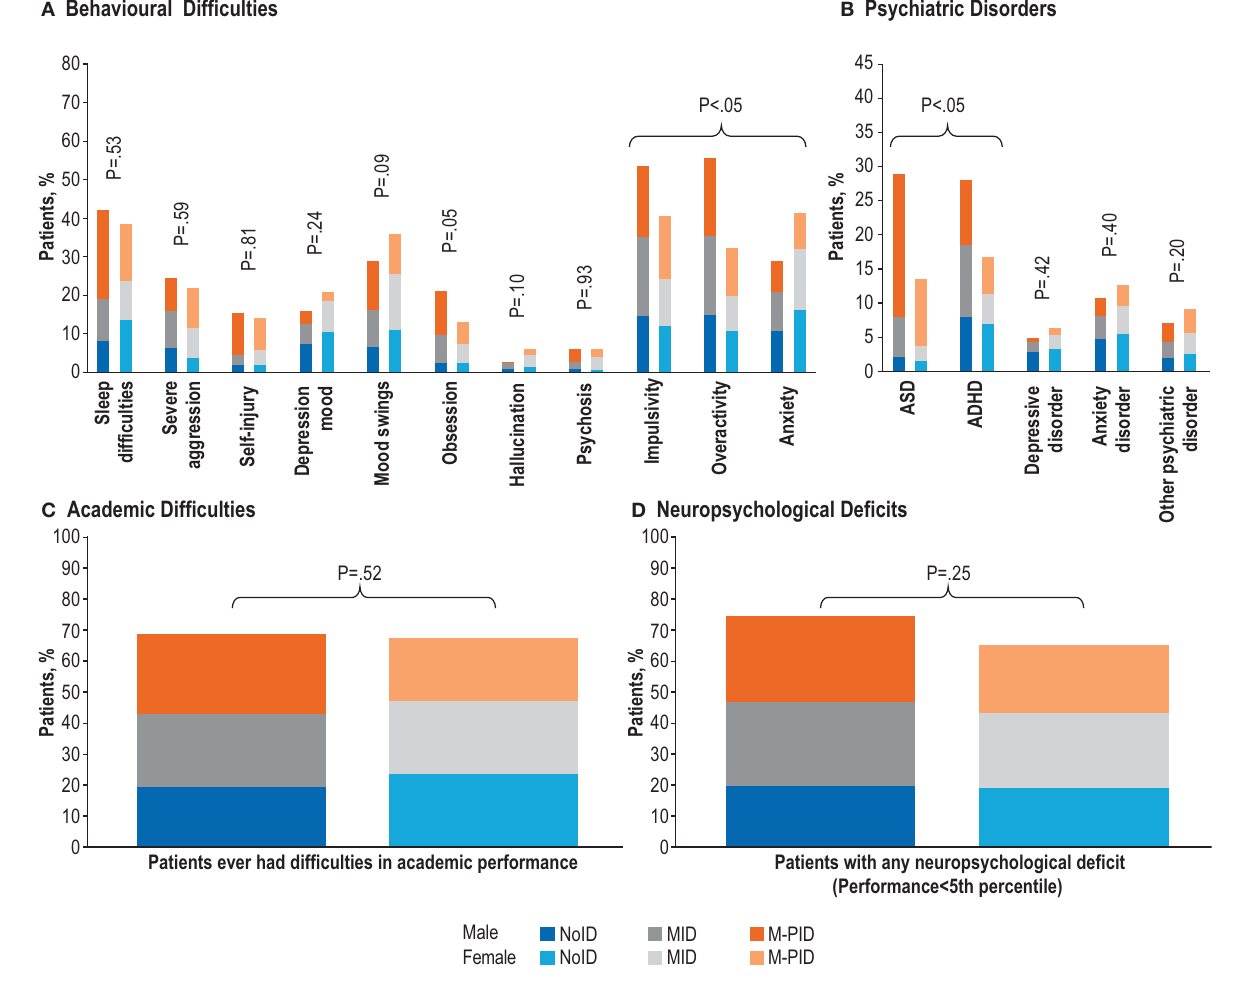
FIGURE 2 | Frequency of TAND features stratified by levels of intellectual ability (noID [IQ > 70], MID [IQ 50–70] and M-PID [IQ < 50]) in male vs. female. (A) Behavioral difficulties. (B) Psychiatric disorders. (C) Academic difficulties. (D) Neuropsychological deficits. Percentages calculated excluding missing/unknown